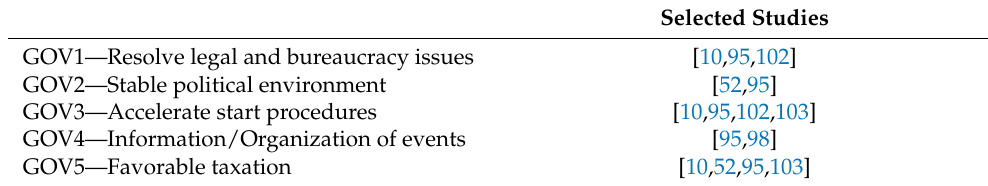
Table 6. Construction of the government interventions factor from the literature.